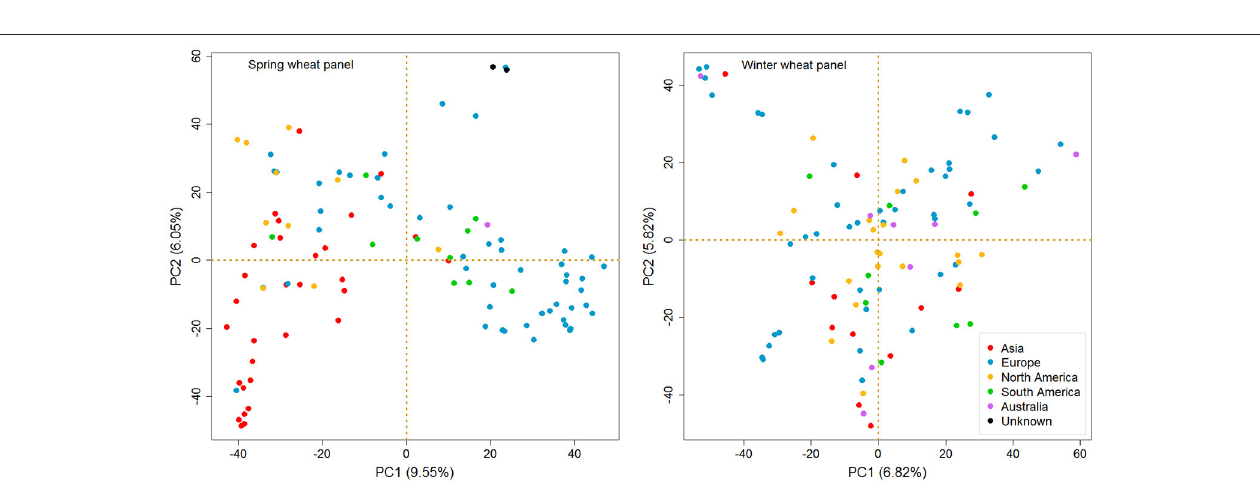
FIGURE 3 | Principal component analysis (PCA) of spring and winter wheat panels based on SNP genotypes (MAF > 5%). The spring wheat accessions bred in Europe and Asia form recognizable clusters, but those bred in the Americas do not. There is no pronounced clustering among winter wheat accessions. Color code is given in the